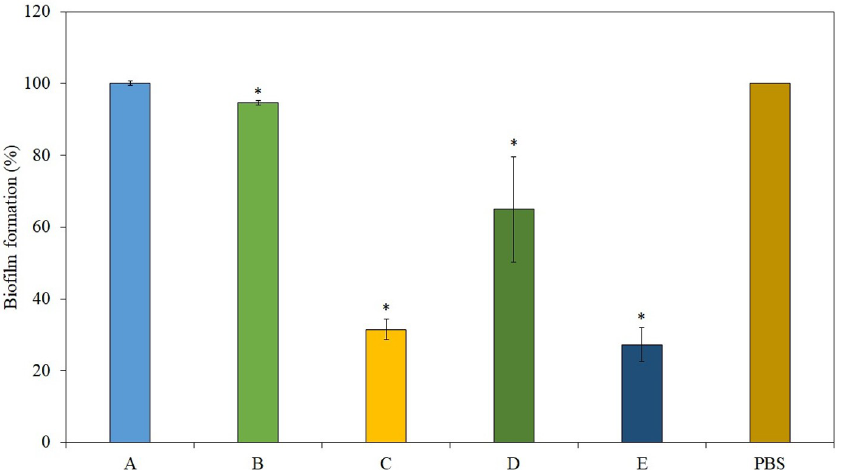
Fig 2. Anti-biofilm functionality of different alcohol-based sanitizers. � indicates P < 0.05 as compared to the control (PBS).